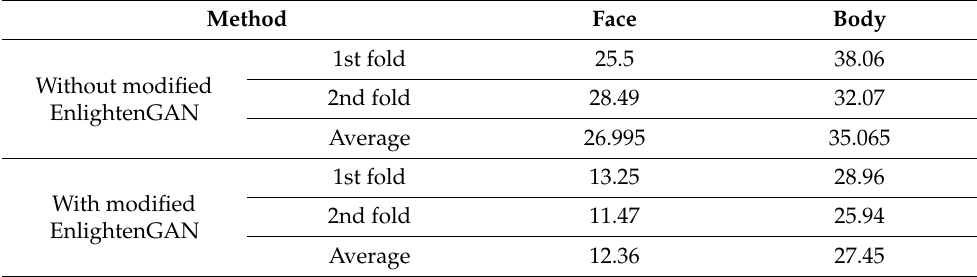
Table 13. Comparisons of EER for face and body recognition with and without modified Enlighten- GAN (unit: %).